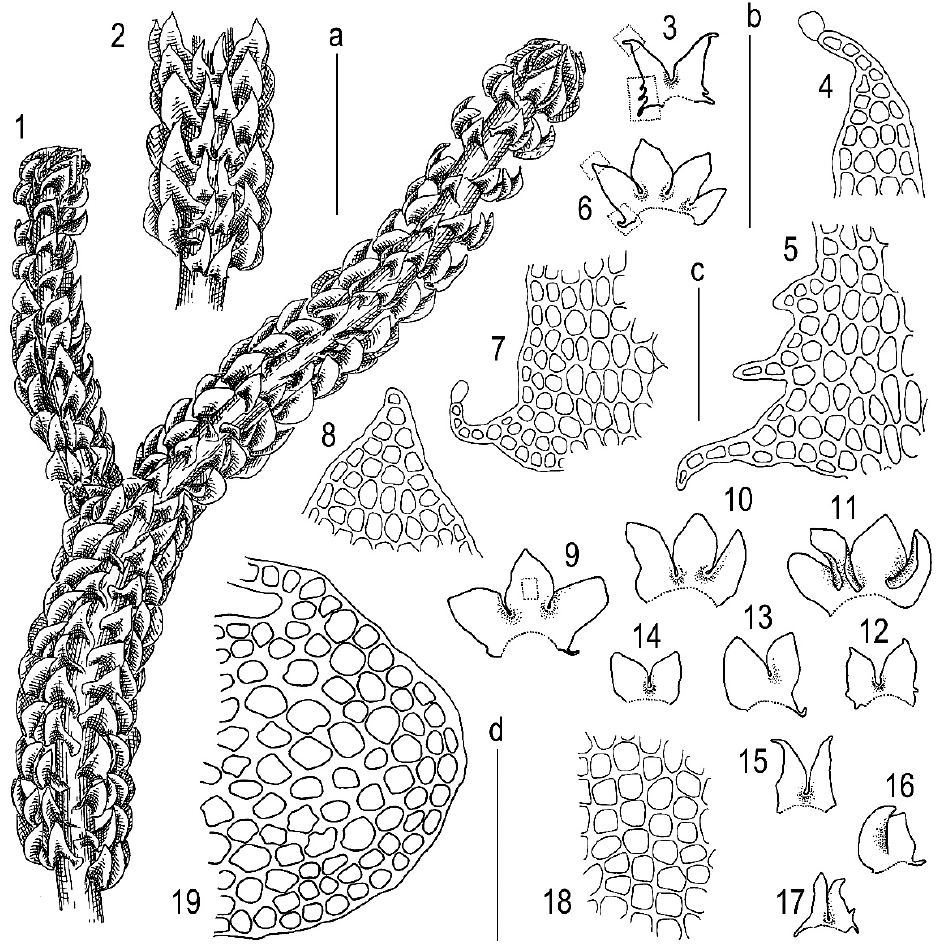
Figure 15. Tetralophozia setiformis (Ehrh.) Schljakov (somewhat depauperate plants): 1 —plant habit. dorsal view; 2 —plant habit. fragment. ventral view; 3 , 12 – 17 —underleaves; 4 —underleaf lobe apex; 5 —underleaf base (from 3); 6 , 9 – 11 —leaves; 7 —leaf lateral base (from 6); 8 —leaf lobe apex; 18 —cells in lobe base; 19 —stem cross section. fragment. Scales: a —1 mm. for 1. 2; b —1 mm. for 3,6,9–17; c — 100 µm. for 4,5,7,8; d —100 µm. for 18,19. All from Prim-81-3-17 (VBGI).